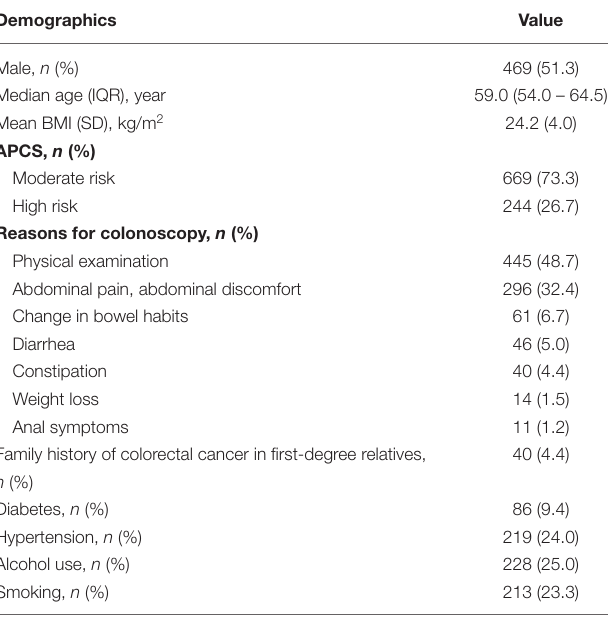
TABLE 1 | Population demographics.